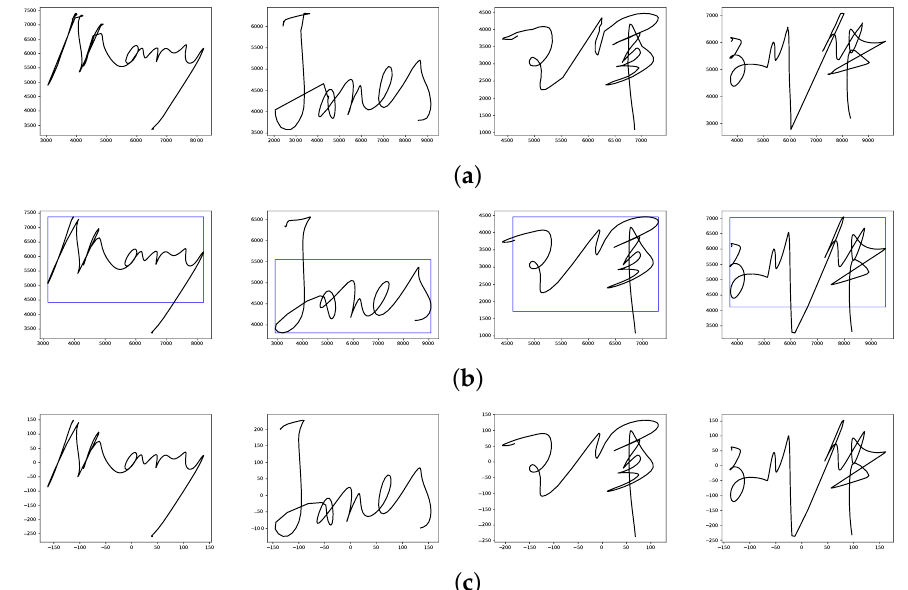
Figure 2. Examples of signature preprocessing. ( a ) Four English or Chinese examples